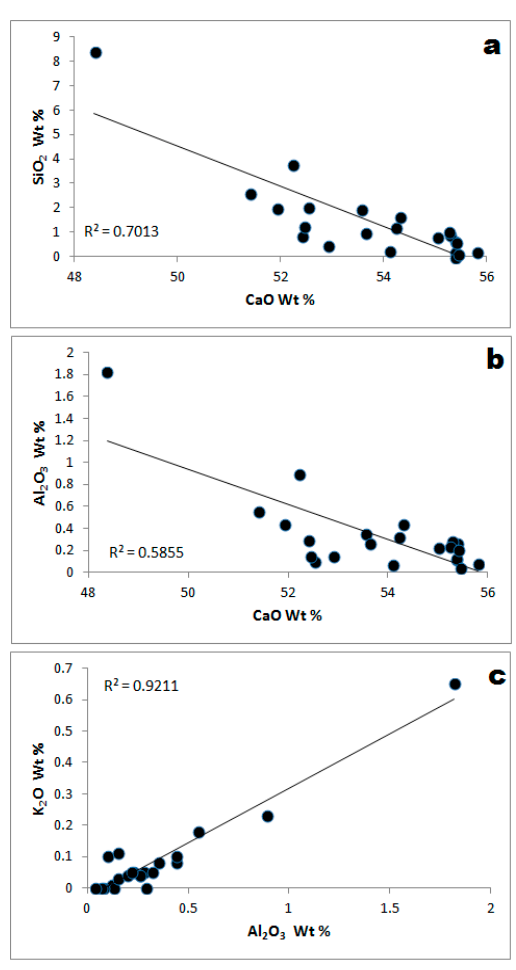
Figure 5. Variation diagrams of: ( a ) CaO versus SiO 2 ; ( b ) CaO versus Al 2 O 3 ; and ( c ) Al 2 O 3 versus K 2 O.